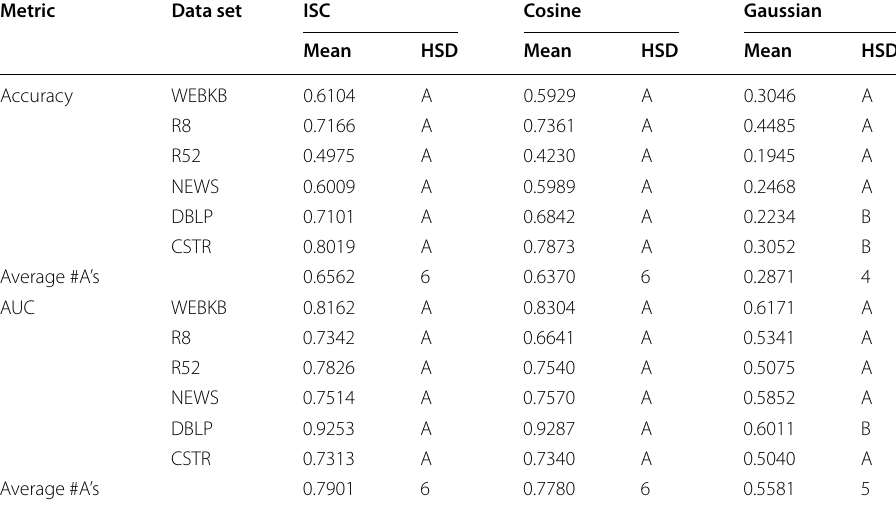
Table 11 Performance of the similarity measures in data sets averaged across all classifica- tion learners Metric